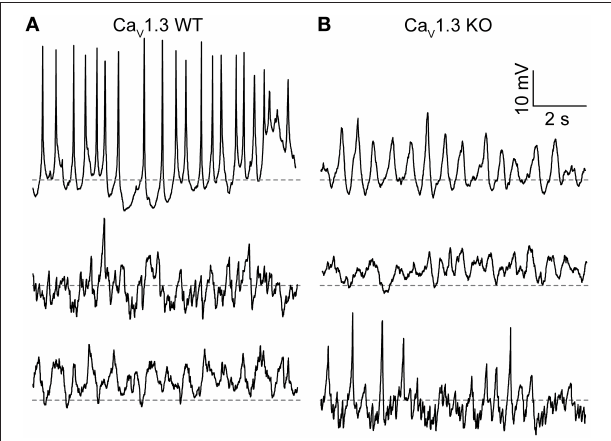
FIGURE 3 | Membrane potential oscillations in Ca V 1.3 WT and Ca V 1.3 KO SCN neurons. (A,B) Representative current-clamp recordings of membrane potential oscillations from Ca V 1.3 WT (A) and Ca V 1.3 KO (B) neurons recorded during the day. Recordings were made in 1 µ M TTX using the same ACSF and 0.9mM control EGTA intracellular solution used to record BK currents. Dotted lines indicate −